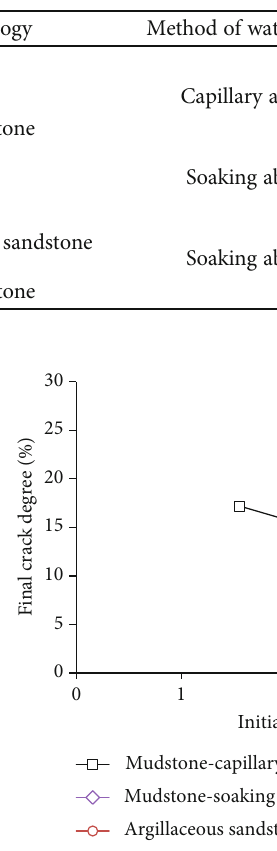
Figure 13: Curves of fi nal fi ssure ratio and initial water content.